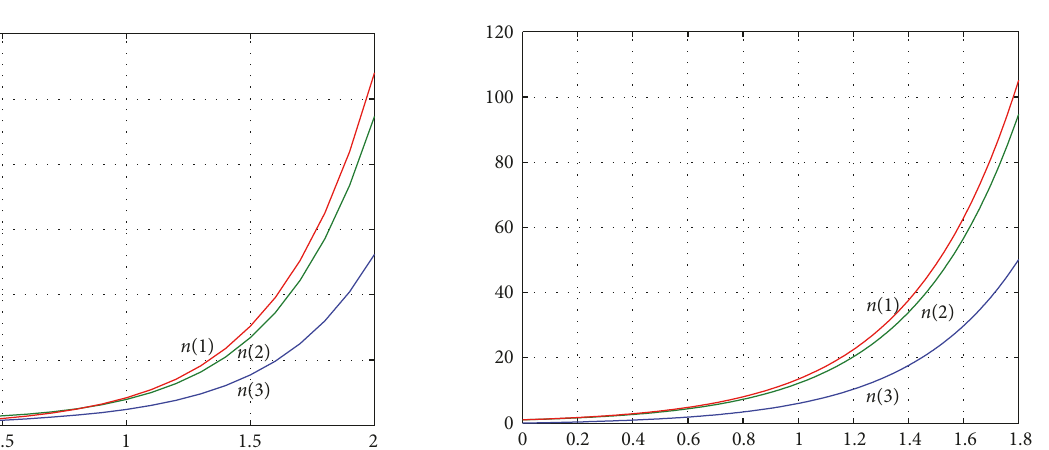
Figure 3: Evolution curve of variables when the initial state set as [0,1, 0] .